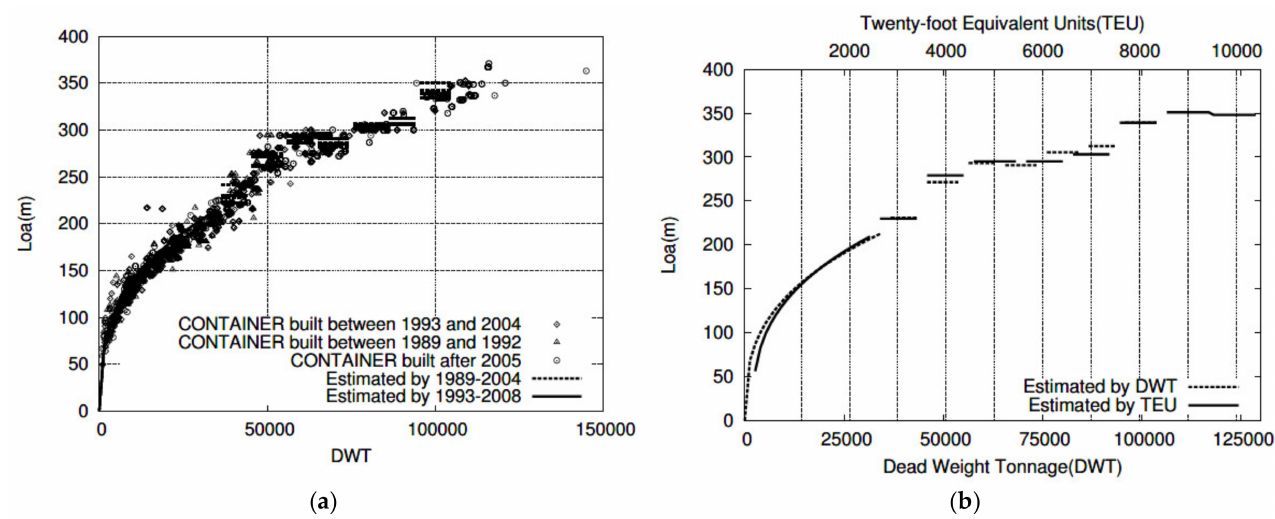
Figure 1. Trends of main dimensions on container ships: ( a ) deadweight tonnage (DWT)–length overall (LOA) regression graph; ( b ) twenty-foot equivalent unit (TEU)/DWT–LOA regression trend line graph (Inoue and Akakura